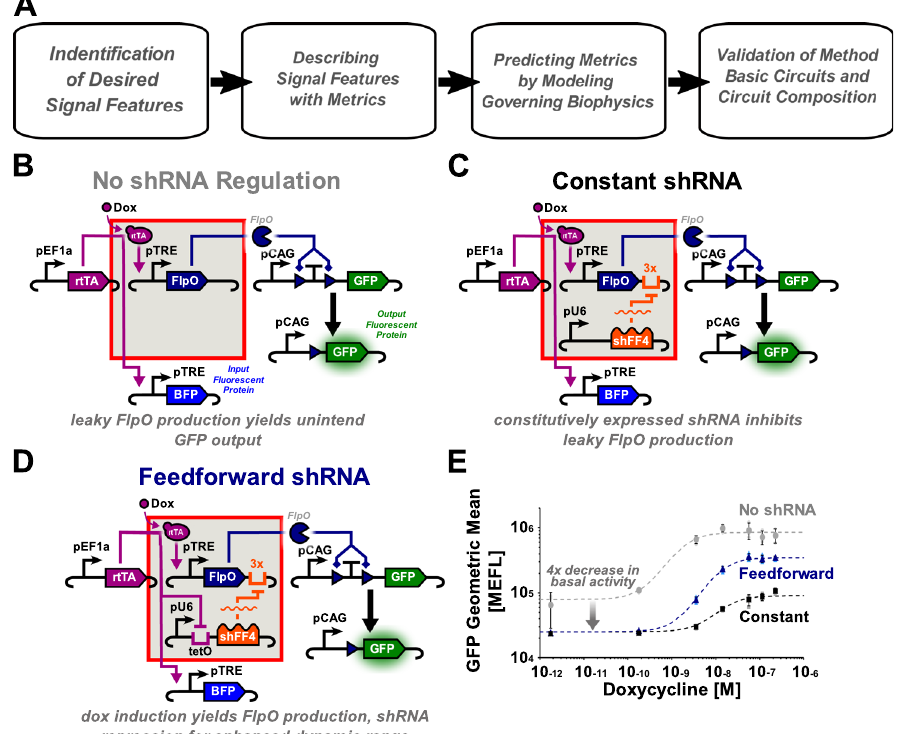
Fig. 1 Characterization fl ow chart and digitizer designs. A Flow chart representing the quantitative standardization demonstrated in this paper. B Recombinase digitizer circuit design connecting a dox-inducible Flp recombinase with an FSF-GFP output and incorporating no-shRNA regulation. C Recombinase digitizer circuit design incorporating constantly expressed shRNA. D Recombinase digitizer circuit design incorporating feedforward regulated shRNA whose expression can be turned off through the induction of rtTA binding to a tet operator (tetO) site. E shRNA serves to mitigate leaky expression, feedforward circuit topology shows enhanced dynamic range under a constrained Flp:shRNA ratio compared with constitutively expressed shFF4. Doxycycline dose response pro fi les of all three recombinase ampli fi er circuits transiently transfected into HEK293FT cells ( n = 3), error bars represent